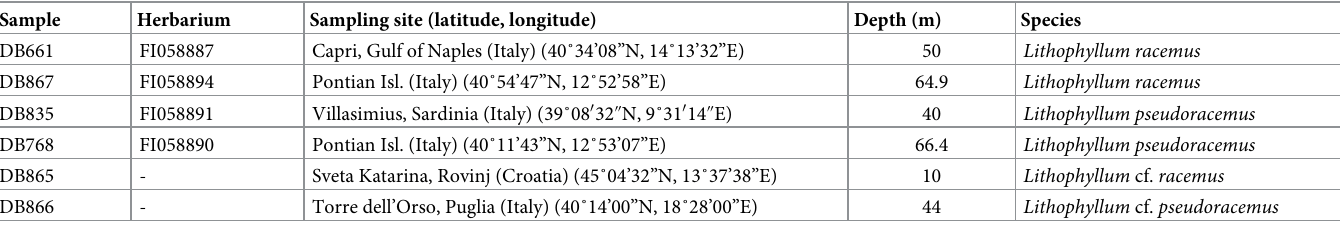
Table 1. L . racemus , L . pseudoracemus , L . cf. pseudoracemus and L . cf. racemus specimens examined under